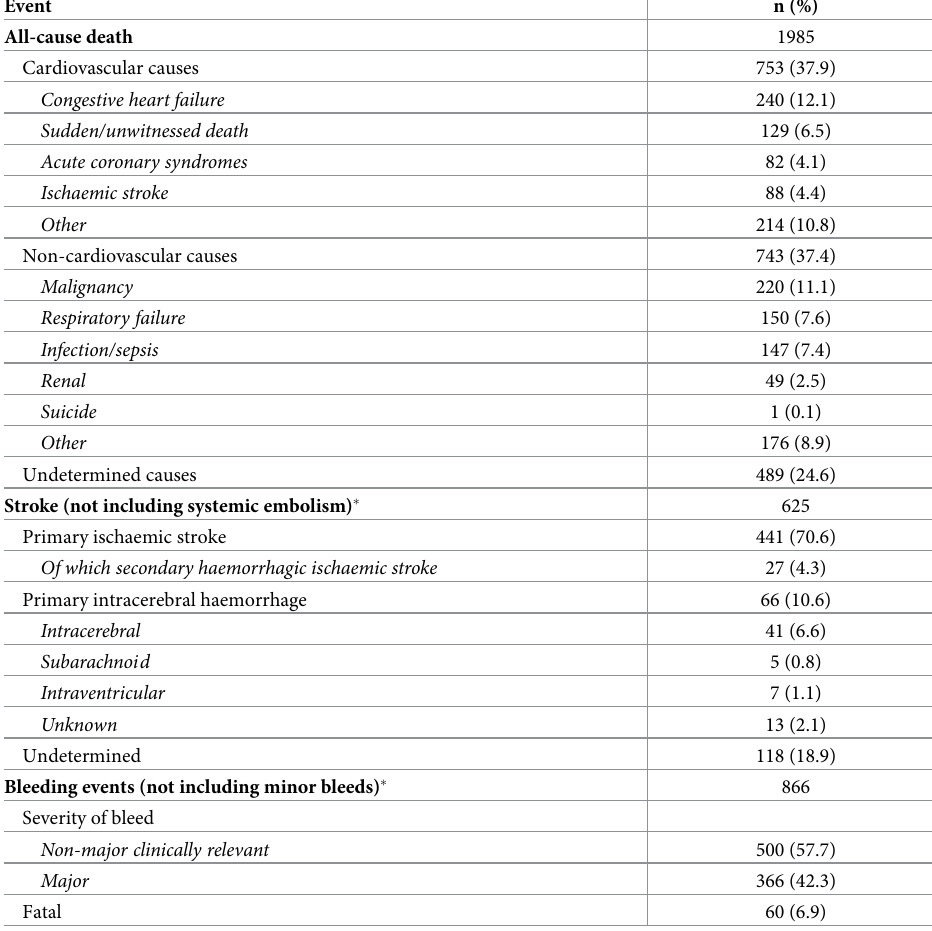
Table 5. Breakdown of primary outcomes by type of event at 2-year